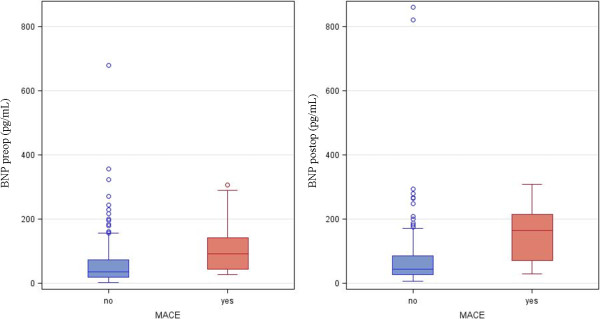
Box plots of preoperative (Preop.) and postoperative (Postop.) BNP levels in the 14 patients with MACE (red bars) compared with the event-free patients (blue bars). P <0.0007 BNP Preop. vs P <0.0001 Postop.